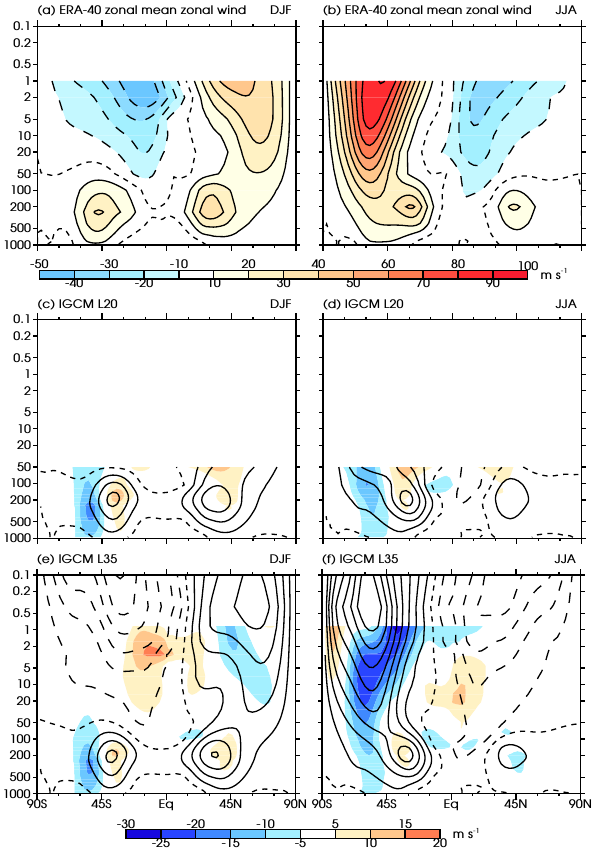
Figure 8. Zonally averaged zonal wind (ms − 1 ) in ERA (a, b) , dif- ference between IGCM4 L20 and ERA (c, d) and difference be- tween IGCM4 L35 and ERA (e, f) in colour shading. In all subfig- ures contours show the total zonal mean zonal wind field (contour interval is 10ms − 1 , negative contours dashed, zero contour dotted). In all cases the left-hand panels display results for the DJF season, and the right-hand panels display results for JJA season. For the reanalysis a mean over the years 1958–2002 is taken.